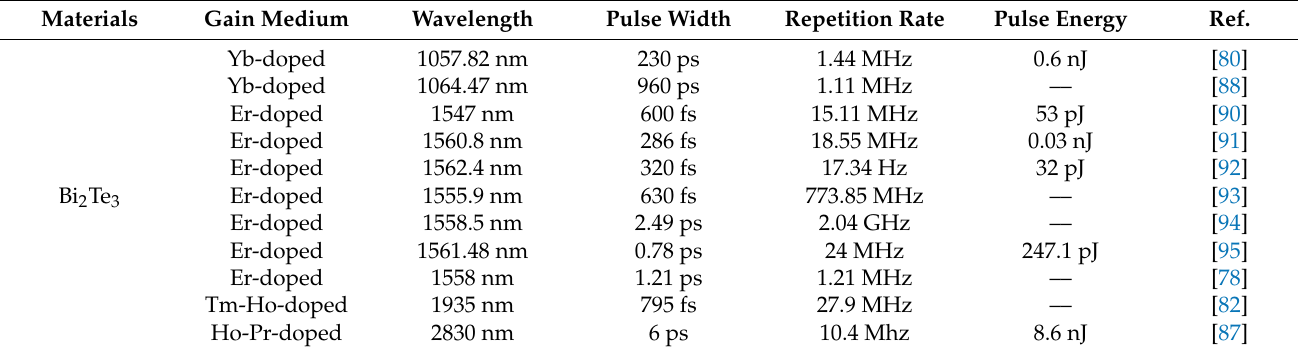
Figure 9. ( a ) Spectrum of the fiber laser at a pump power of 230 mW. ( b ) A typical mode-locking pulse train. ( c ) RF spectrum of the mode-locked laser. Inset: spectrum in 1 GHz span. ( d ) Autocorrelation trace. Reproduced from ref. [81]. Optical Society of America, 2014. Table 3. Summary of passively mode-locked fiber lasers with TI materials.